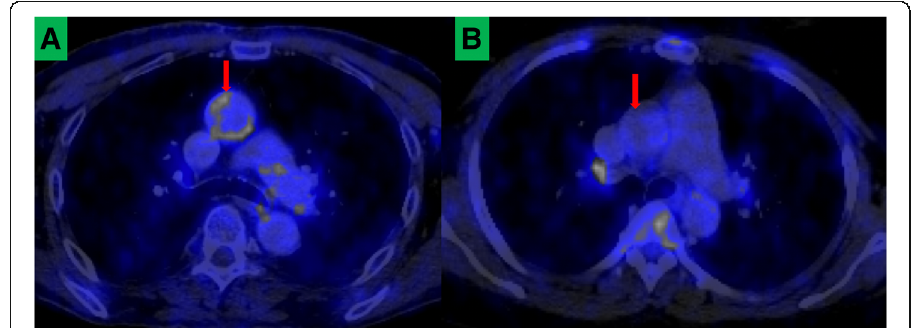
Fig. 1 F-18 FDG PET/CT images showing axial sections through the chest of an HIV-infected patient ( a ) and HIV-uninfected patient ( b ) matched for age and gender. Increased F-18 FDG uptake is seen in the ascending aorta (red arrow) of the HIV-infected patient but not in the HIV-uninfected